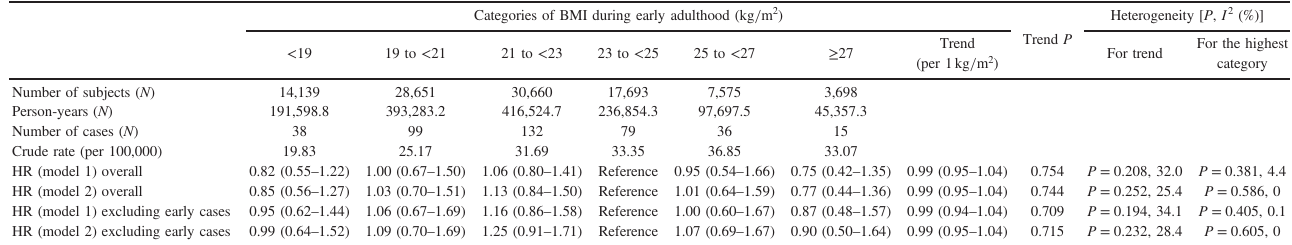
Model 1 adjusted for age and area (within each study for JPHC and JACC). Model 2 adjusted for age, area, smoking (pack-years [PY] = 0, 0 < PY ≤ 20, >20, or unknown), drinking (never, <1 week = day, current <23g = day, ≥ 23g = day, or unknown), and history of diabetes (yes, no, or unknown). HRs values in bold show statistical signi fi cance. BMI during early adulthood was evaluated only in JPHC II, JACC, Takayama, Miyazaki, and